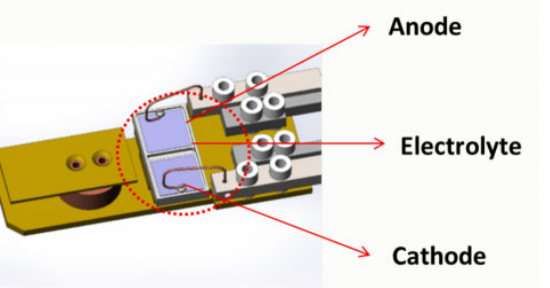
Figure 3. Schematic of an XPS sample holder. Reprinted with permission from ref. [17]. Copyright 2017 American Chemical Society Publications.